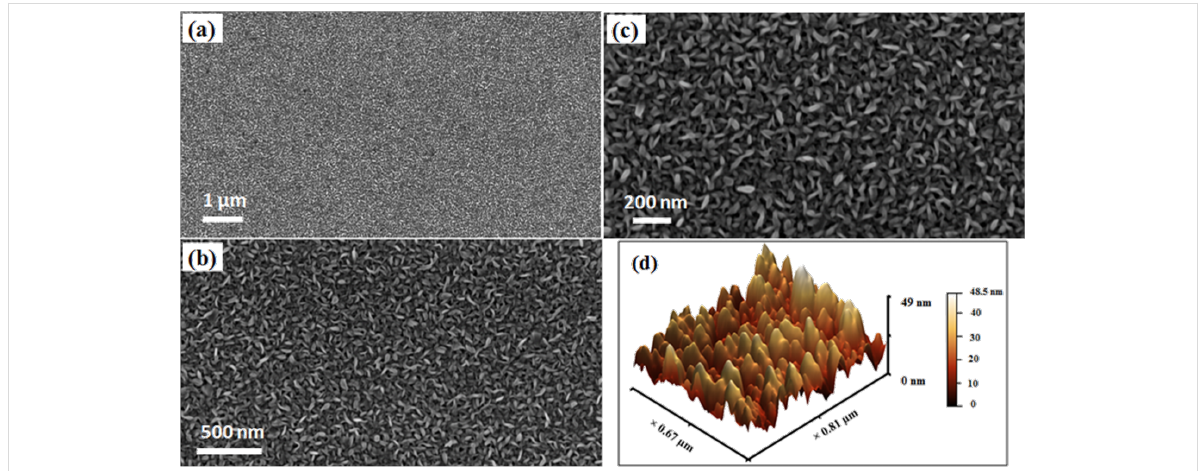
Figure 1: (a – c) Typical field-emission SEM images with different magnifications of MoS 2 NSs grown by double sulfurization of a 50 nm Mo film at 850 °C on SiO 2 /Si substrates; (d) AFM image: 3D image of panel (b) in Figure S1.